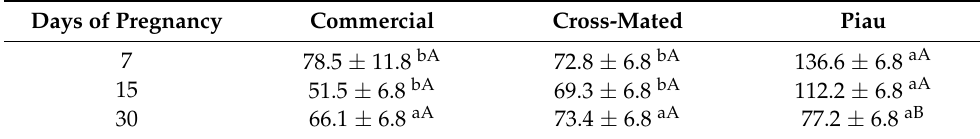
Table 2. Number of blood vessels (per 10 6 µ m 2 ) according to the days of pregnancy in commercial gilts and Piau breed gilts mated with commercial males (cross-mated) and Piau breed males (Piau) (Mean ± SE).